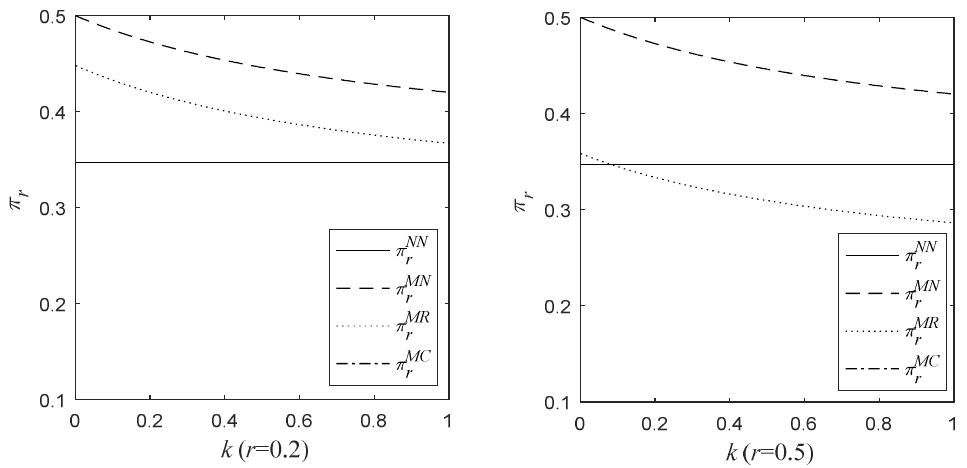
Figure 2. The impact of the percentage of residual value per unit of returned product value impair- ment on the profit of offline retailers.